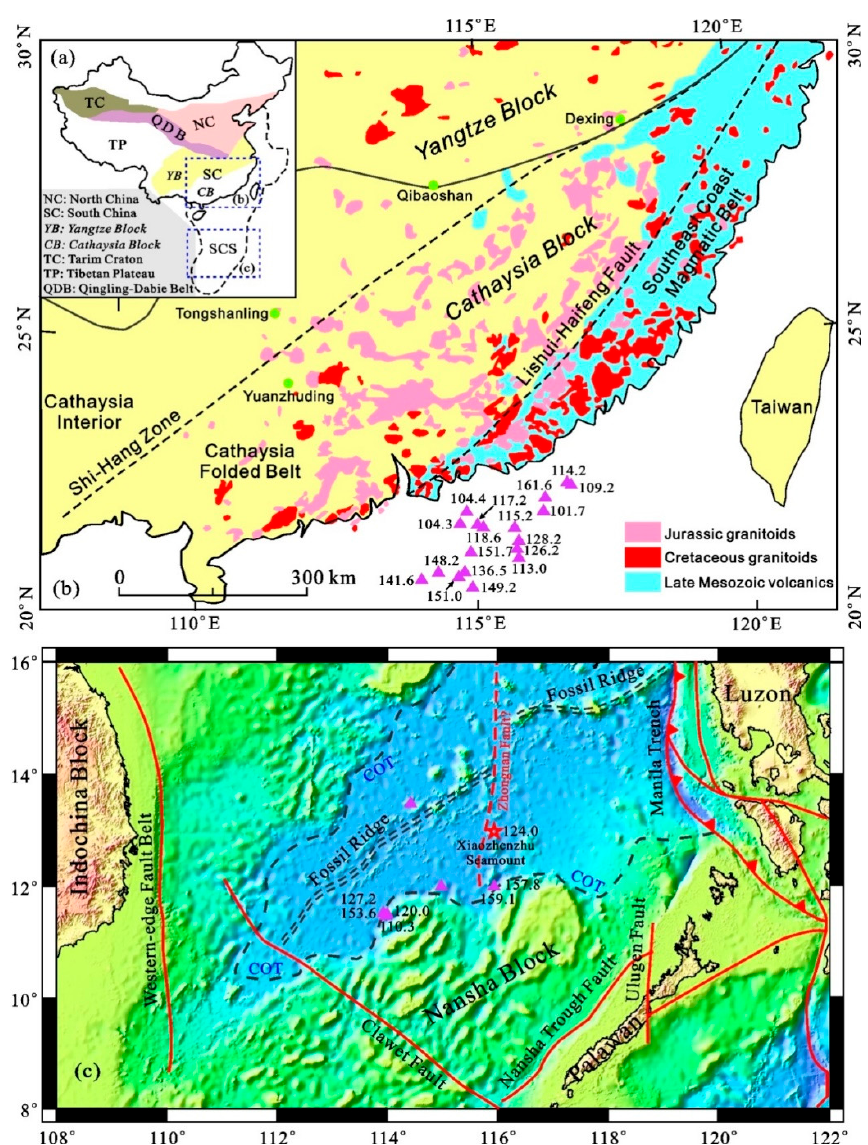
Figure 1. ( a ) Sketch tectonic map of China. ( b ) Simplified geological map showing the distribution of Mesozoic igneous rocks within the South China Block. The South China Block comprises the smaller Yangtze and Cathaysia blocks, with the Shi-Hang Zone and the Lishui-Haifeng Fault further dividing the Cathaysia Block into three tectonic units: the Cathaysia Interior, the Cathaysia Folded Belt, and the Southeast Coast Magmatic Belt. ( c ) Bathymetric map of the central-southern part of the SCS showing the sampling site (Xiaozhenzhu Seamount, red star) and age (Ma). The solid purple triangles and associated values indicate the locations and ages (Ma) of samples collected in previous studies [23–26].